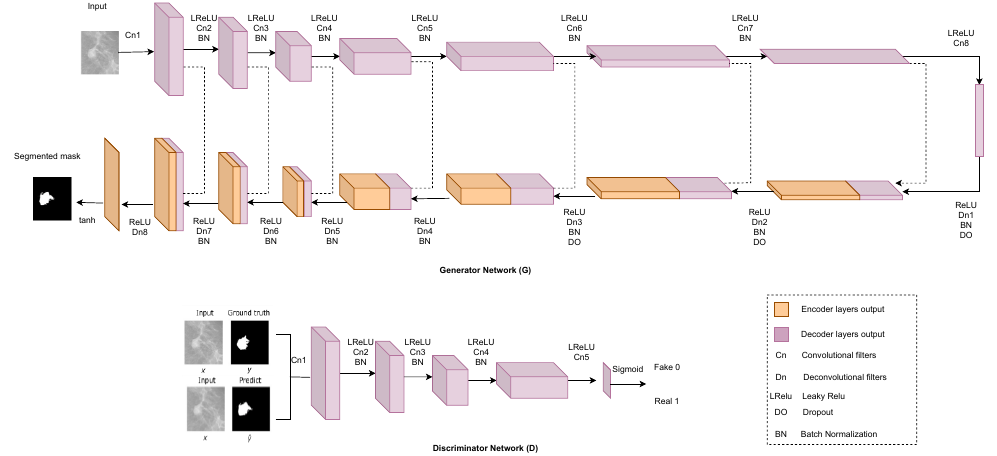
Figure 8. A cGAN Architecture: generator G ( top ) and discriminator D ( bottom ). Shams et al. [93] constructed a deep generative multi-task (DiaGRAM), which was built upon the ensemble of CNN and GAN to reduce the mortality rate in BrC. DiaGRAM